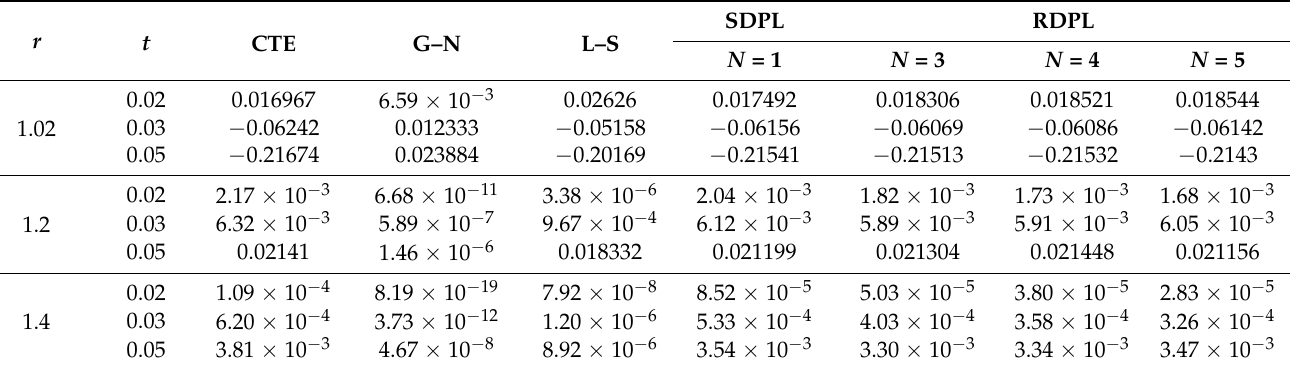
Table 2. Effects of dimensionless time t on radial displacement u according to different thermoelastic- ity theories with several values of r .